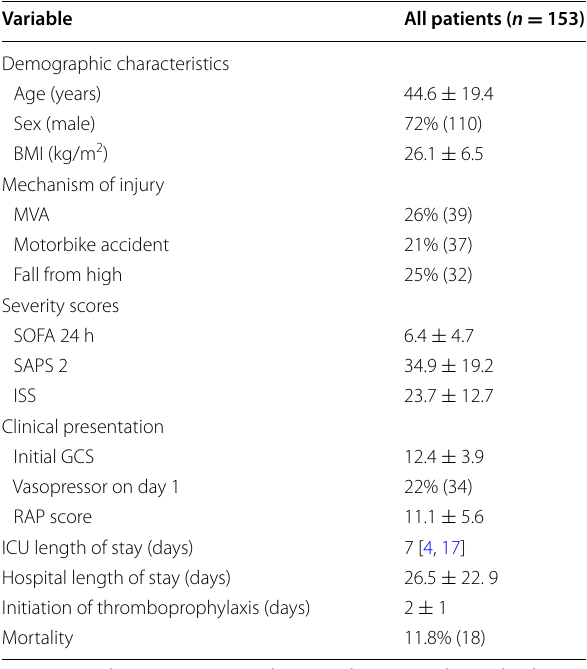
Table 1 Demographic and clinical characteristics of included